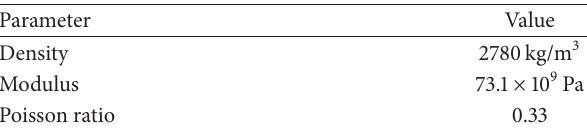
Figure 2: The wing structural model. Table 2: Material